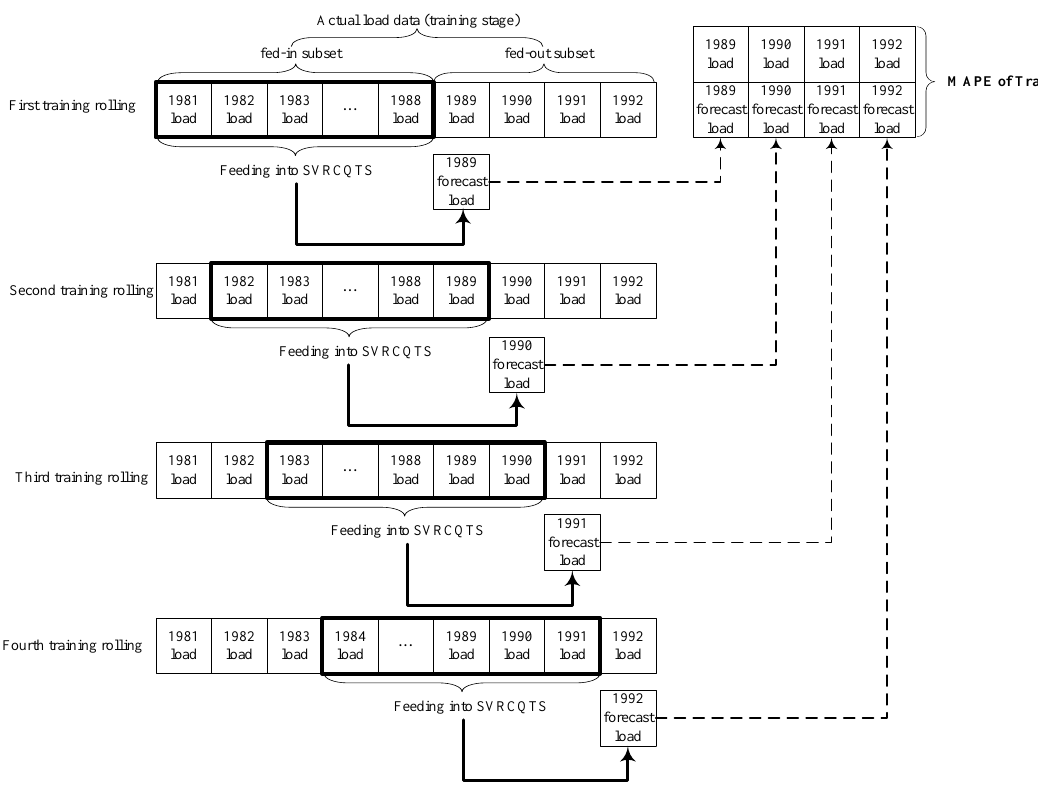
Figure 2. The rolling-based forecasting procedure.